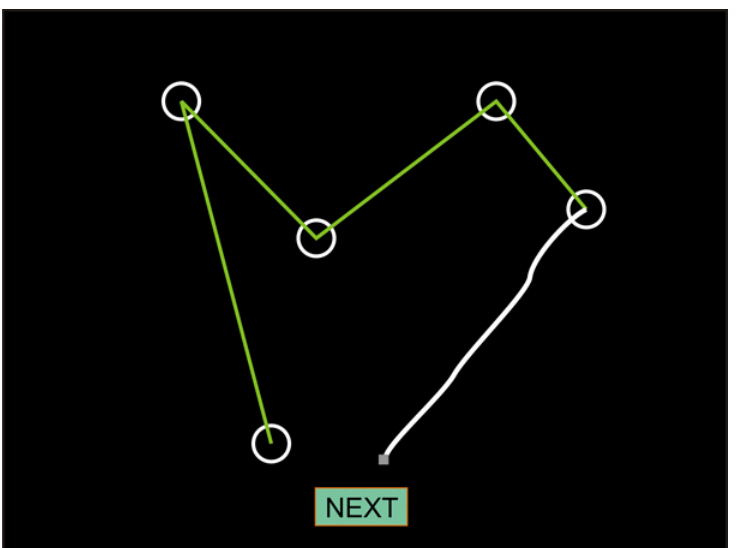
Fig 1. The design fluency test. Participants connected circles on the display with four lines drawn with the mouse. As each line was drawn, the path was shown in white. When the cursor crossed a circle, it was included in the figure and connected with the previously selected circle by a straight green line. When a design was finished, participants moved the cursor (small gray square) to click the “ NEXT ” box to advance to the next